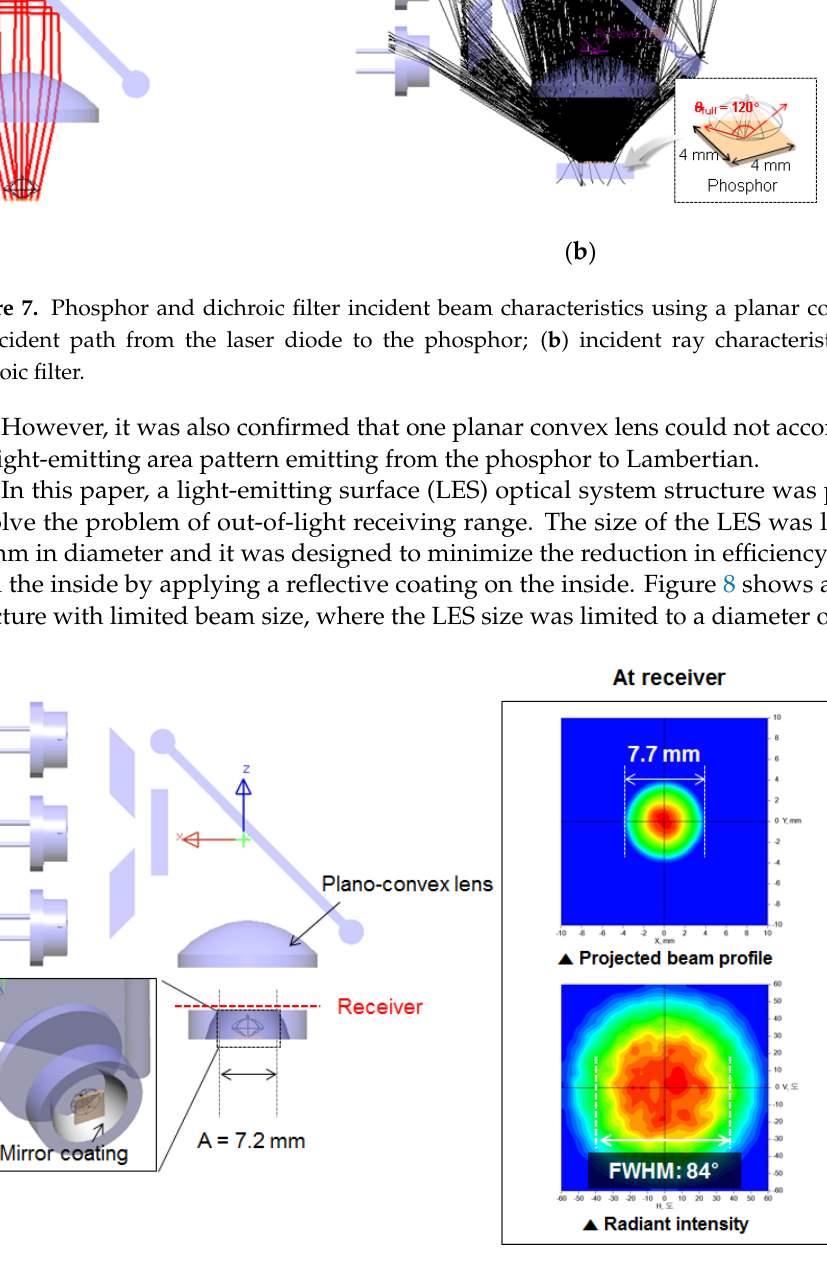
Figure 8. Proposed optics limited to a beam size of 7.2 mm.